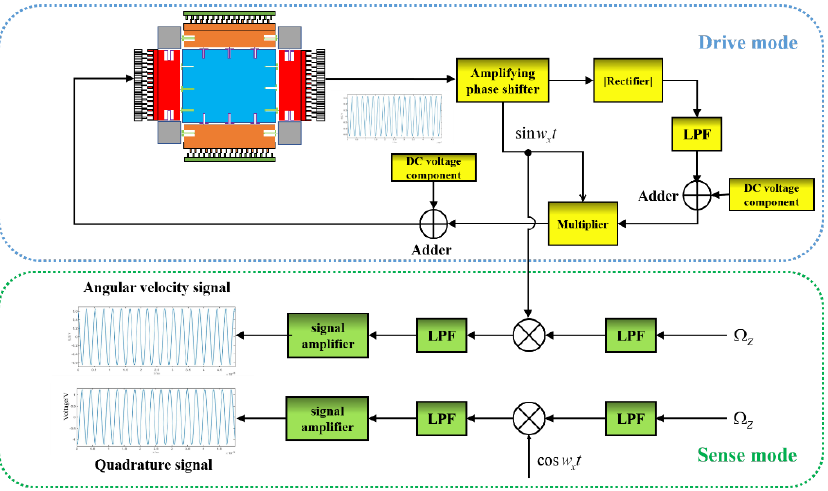
Figure 2. Circuit structure of MEMS gyroscope.